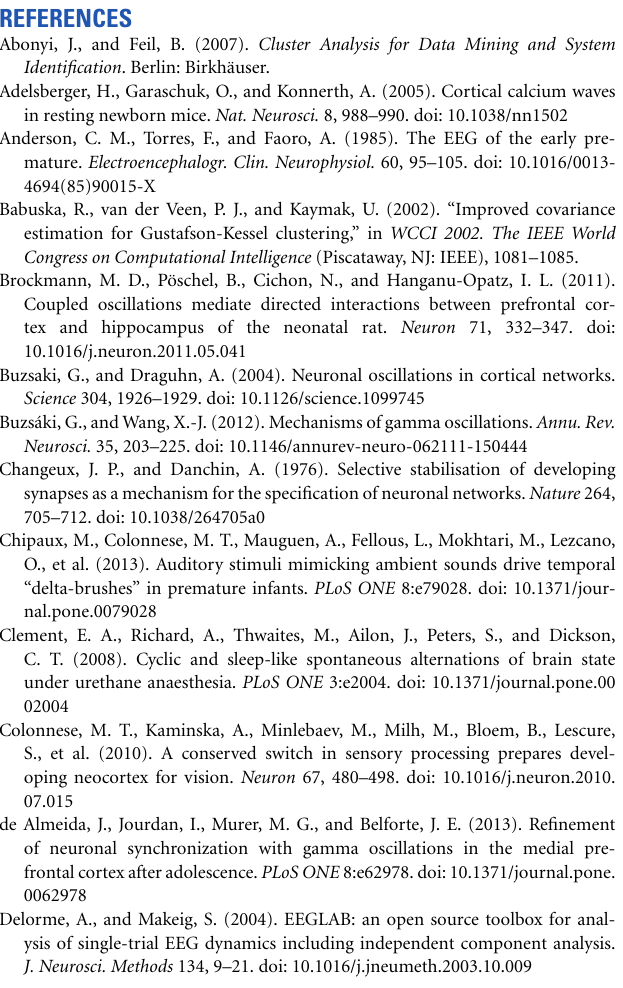
Figure S1 | Detection of oscillatory events. Histograms of root-mean-squared (rms) amplitude (gray) of the recorded LFP from a P8 (A) and P12 (B) rat. Black curves display the Gaussian functions fitted to the left part of the rms histogram (values from 0 to the histogram peak) which corresponds to the time-windows of suppressed oscillatory activity. Figure S2 | Unsupervised classification using k-means clustering. (A) Classification of oscillatory events from the same data set as shown in Figure 4A . Each dot corresponds to the projection of the feature vector of one event (SB in blue, NG in red) into principal component space spanned by the first two principal components. (B) Reliability of the k-means classification in relationship to the number K of used PCs for the oscillatory events in the upper (light gray) and lower PL (dark gray) of neonatal rats ( n =